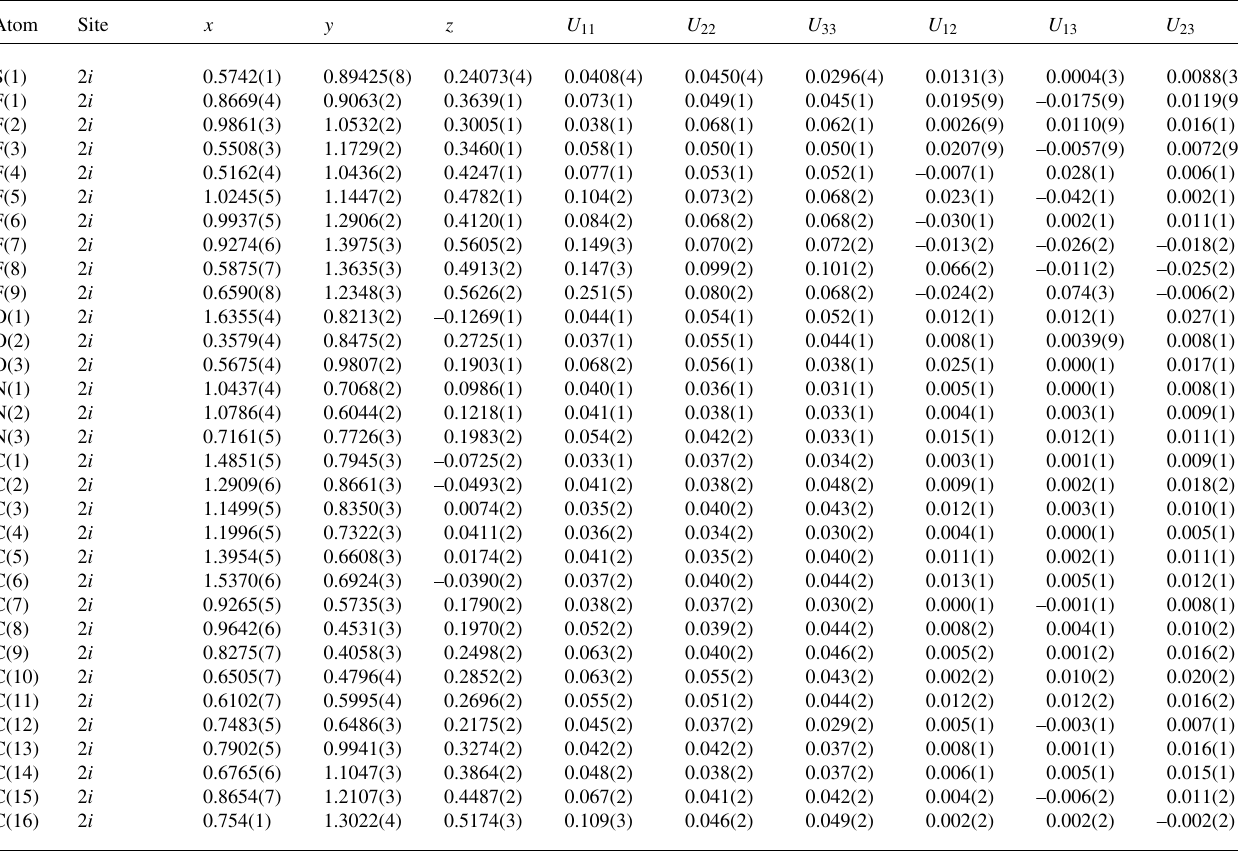
Table 3. Atomic coordinates and displacement parameters (in Å 2 )